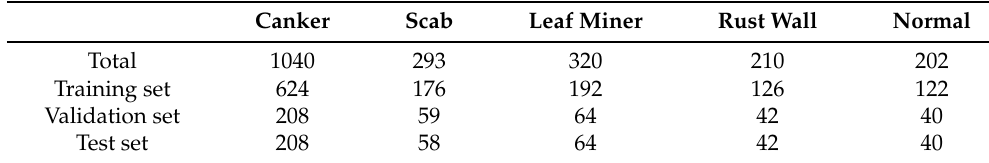
Figure 1. Examples of leaves/fruit of citrus pests and diseases. ( a ) Citrus canker disease. ( b ) Cit- rus scab disease. ( c ) Citrus leaf miner insect-pests. ( d ) Rust wall insect-pests. ( e ) Citrus normal leaf/fruit picture. Table 1. Distribution of various data on citrus pests and